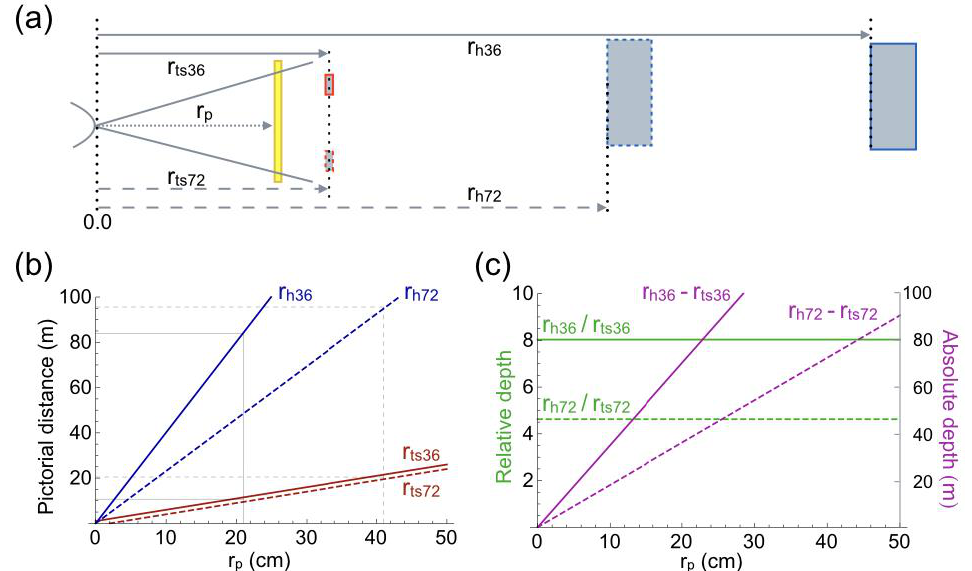
Figure 3. Geometry of the pictorial scenes of Figure 1a,b. ( a ) Top view of the pictorial scene. Sizes and distances of objects are not to scale. Distances were computed for the traffic signs (r ts36 and r ts72 ) and house (r h36 and r h72 ) depicted in the two pictures. The viewer (curve at the left side) is looking at the pictures (yellow bar) from a distance r p . ( b ) Pictorial distances of traffic signs and houses that produce the same retinal images as their projections in the pictures. Distances are computed as function of r p . Thin lines mark the viewing distances at which the computed distances are equal to the physical distances (see Figure 2a). ( c ) Relative (green) and absolute (magenta) depth between the computed distances of traffic signs and houses as function of r p .